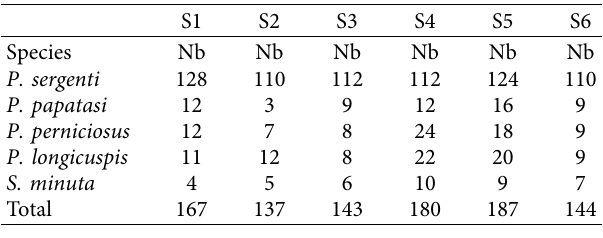
Table 3: Number of sandfies at the studied stations.